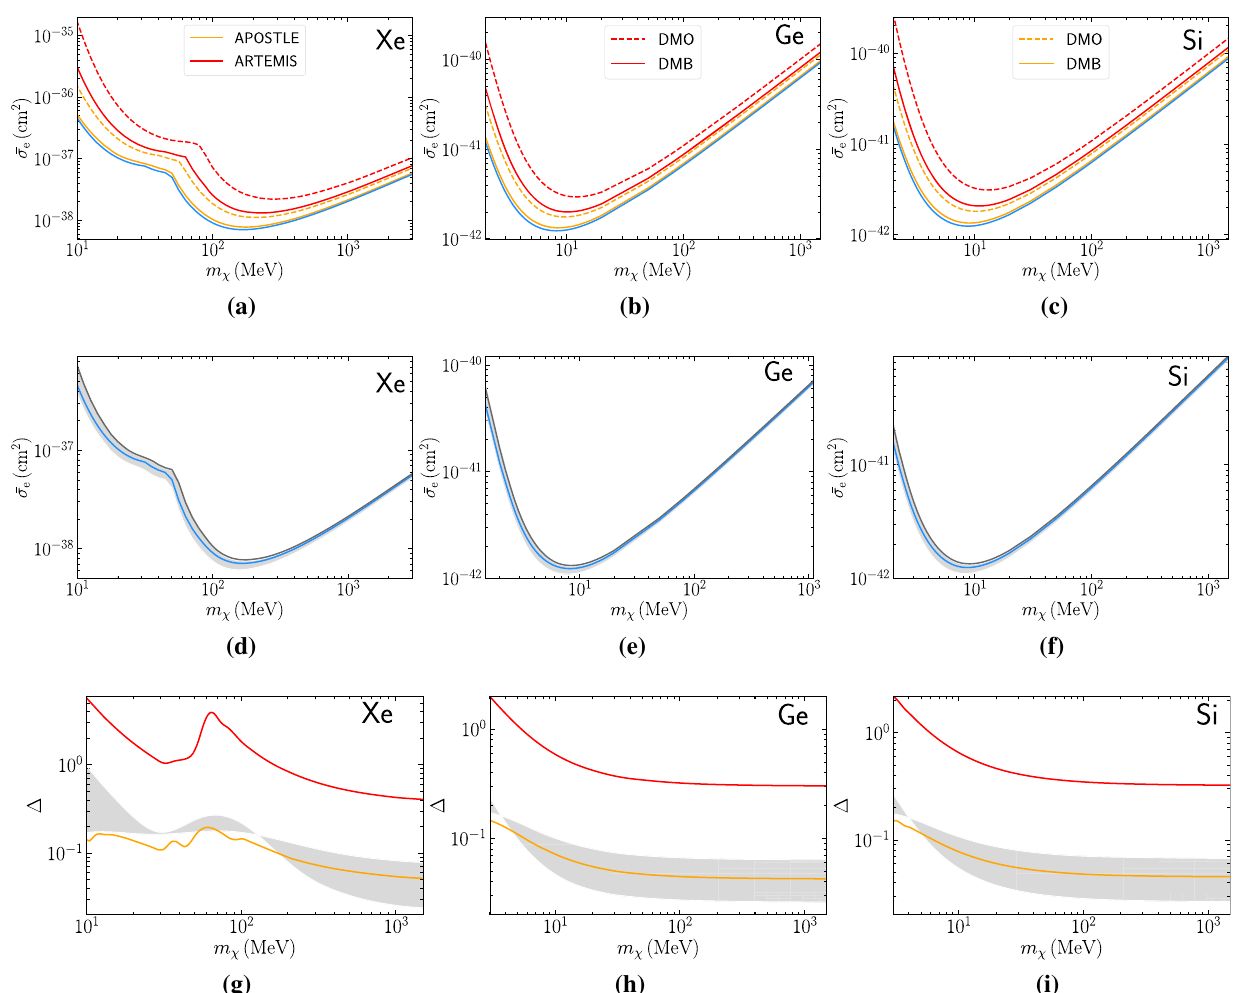
Fig. 4 Variations in the exclusion bounds for the Double Power Law with F DM = 1. In both the middle and lower panels k = 1 . 5 is represented by the gray region. The other relevant details are same as of Fig. 3 v = 528 + 24 = 1 . 5. We have also shown esc − 25 km/s for k